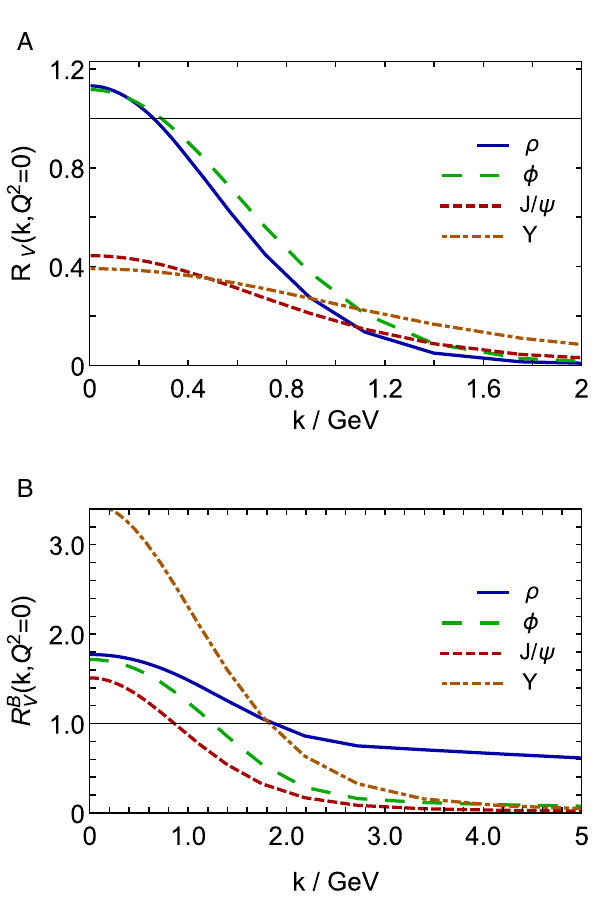
Fig. 2 Upper panel – A : Ratio in Eq.(37) computed using matched solutions of the gap and Bethe–Salpeter equations defined by Eqs. (18), (33) for V = ρ,φ, J /ψ,ϒ . Lower panel – B : Ratio in Eq.(40), com- puted analogously. In cases where the VMD hypothesis were sound, all these curves would lie close to the thin horizontal line drawn at unity.